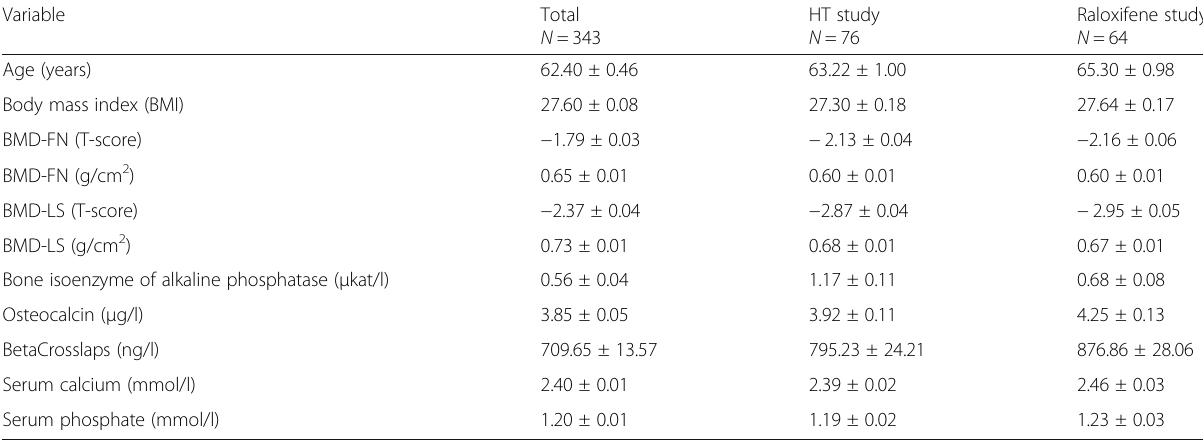
Table 1 General characteristics of the studied groups of women